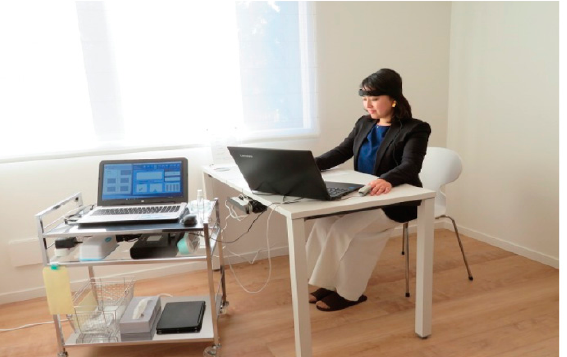
Figure 3. Subject attaches the probe to its head. After starting the EEG measurement, they begin to perform the tasks of calculation, memorization, and rest, according to the PC navigation.